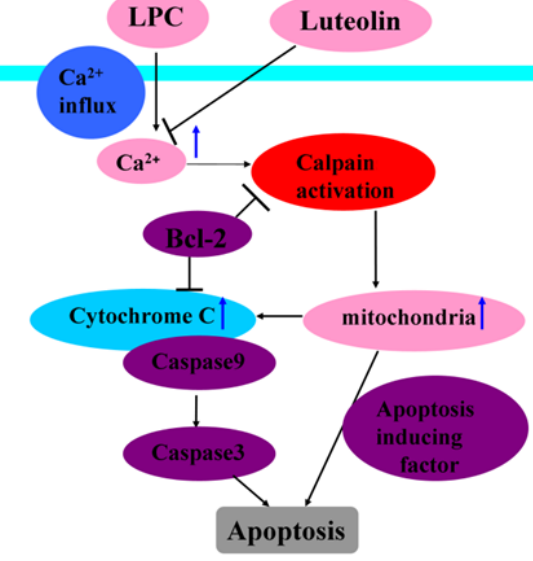
Figure 3. Possible mechanisms of luteolin inhibiting LPC-induced apoptosis in endothelial cells through the blockage of the calcium-dependent mitochondrial